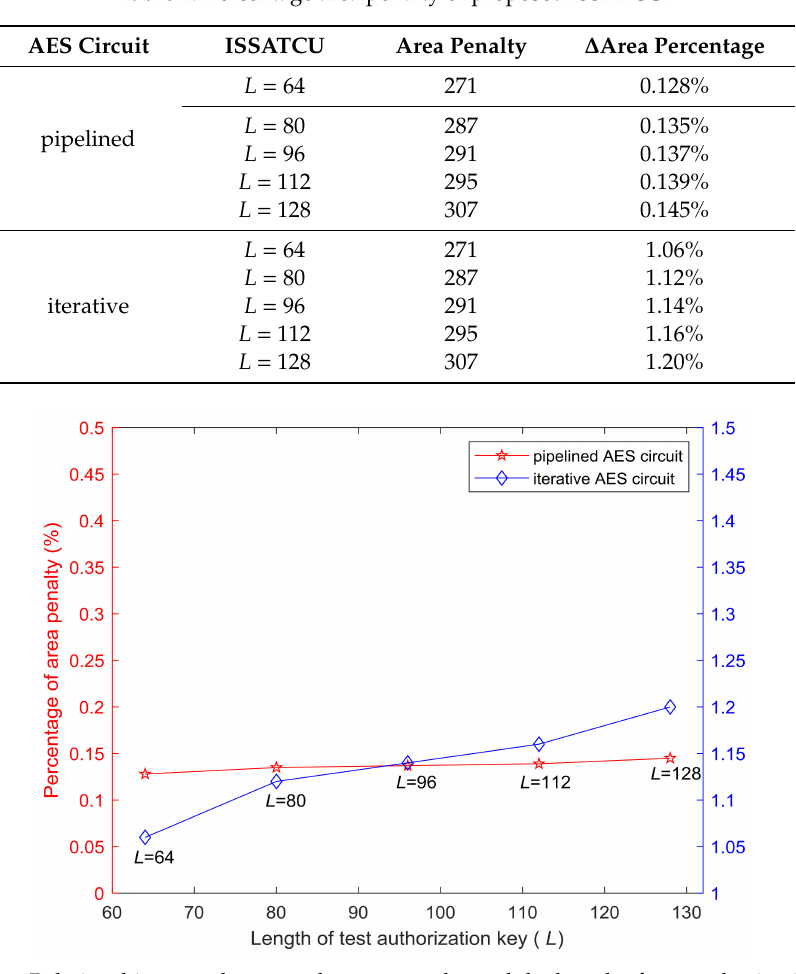
Figure 10. Relationship curve between the area penalty and the length of test authorization